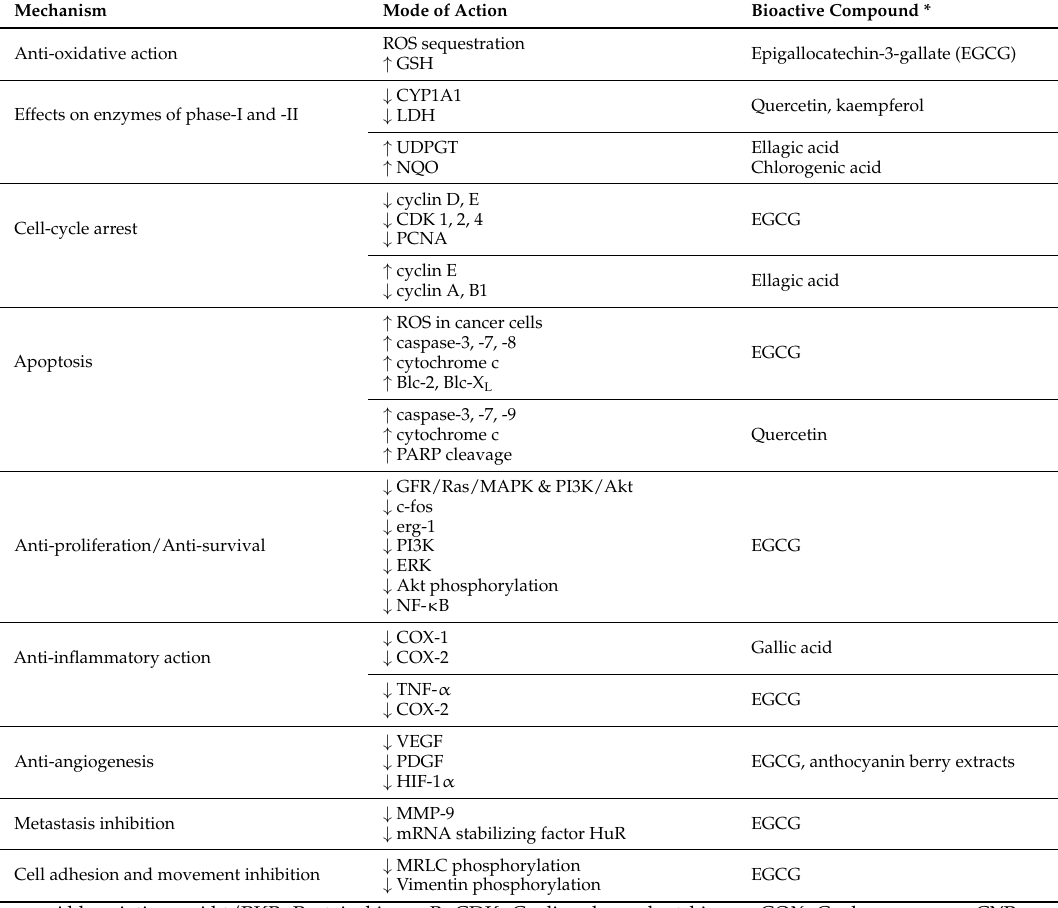
Table 2. Summary table of mechanisms and mode of action via which berries may evoke chemopreventive and therapeutic responses against